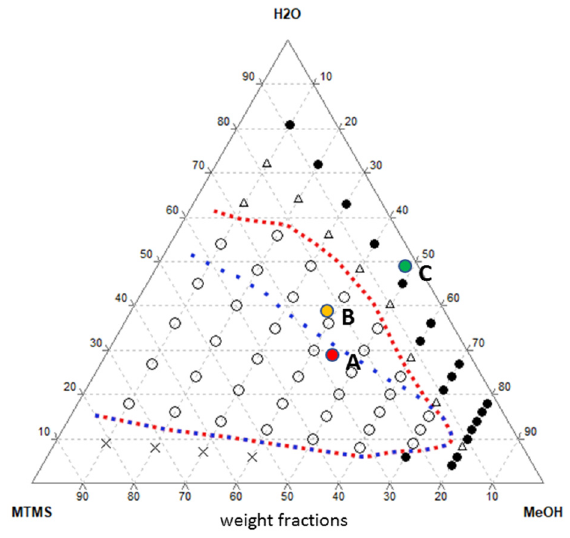
Figure 2. Sol–gel synthesis of MTMS-based gels described on the ternary system (Gibbs triangle), with synthesis composition for investigated samples A–C. Red line — binode, blue line — spinode, with synthesis composition for investigated samples A–C. Red line—binode, blue line—spinode,  — silica resin, ○— monoliths, Δ — macroscopic phase separation, ● — precipitate. —monoliths, ∆ —macroscopic phase separation, •